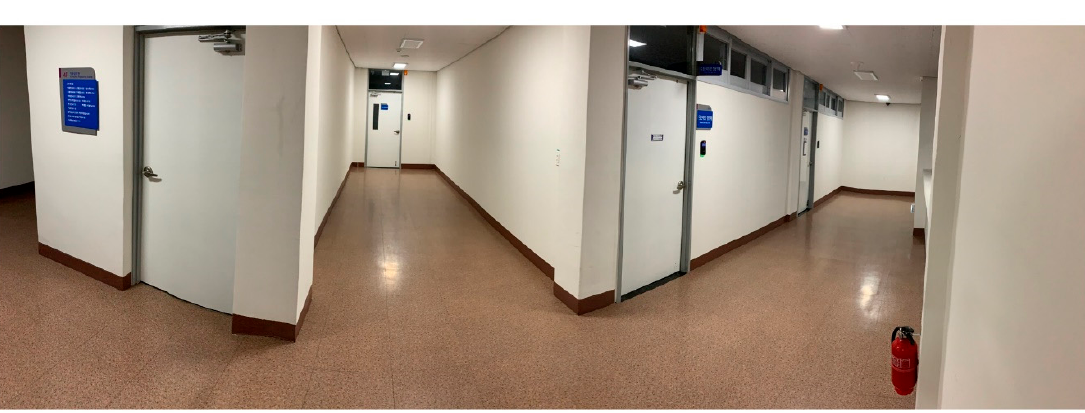
Figure 22. Indoor space (corridor) wherein second and third autonomous scanning experiment was performed (panoramic view).